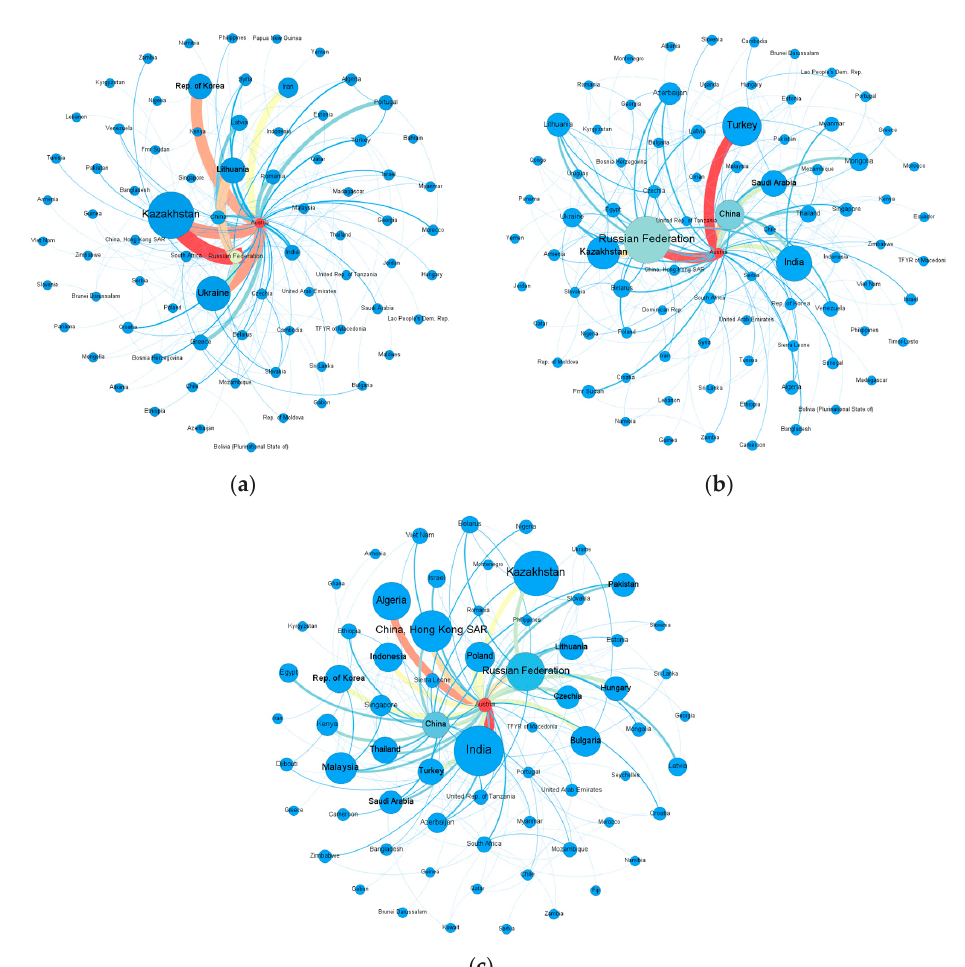
Figure A1. Trade networks of maintenance or service vehicles products in the BRI region. ( a ) phase 1 (2003–2008), ( b ) phase 2 (2009–2013), ( c ) phase 3 (2014-2017). The settings are the same as in Figure 7.